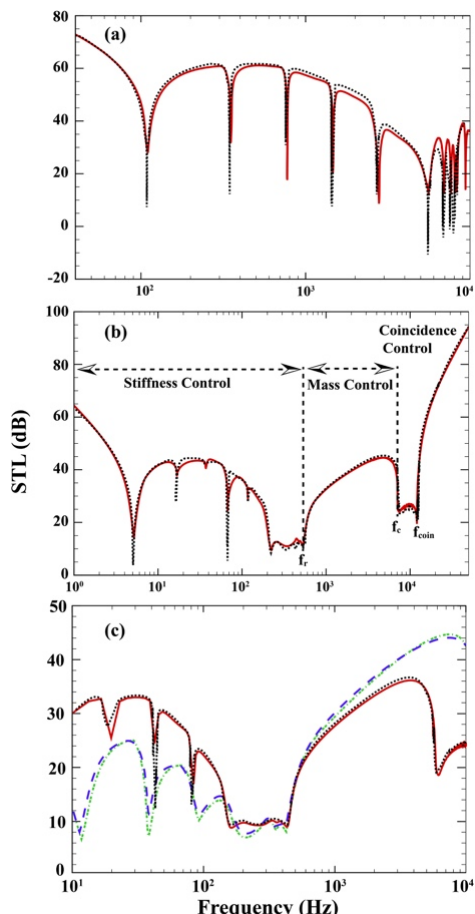
Figure 4. ( a ) Comparison study of STL curves for single elastic cylindrical shell, red solid line: present, black dotted line: Ref [55]. ( b ) Comparison study of STL for single elastic cylindrical shell, red solid line: present, black dotted line: Ref [71]. ( c ) Comparison study of STL for single elastic cylindrical shell under an external flow, red solid line: present ( M = 0), black dotted line: Ref [63] ( M = 0 ) , purple dashed line: present ( M = 0.5), green dashed-dotted line: Ref [63] ( M = 0.5 ).